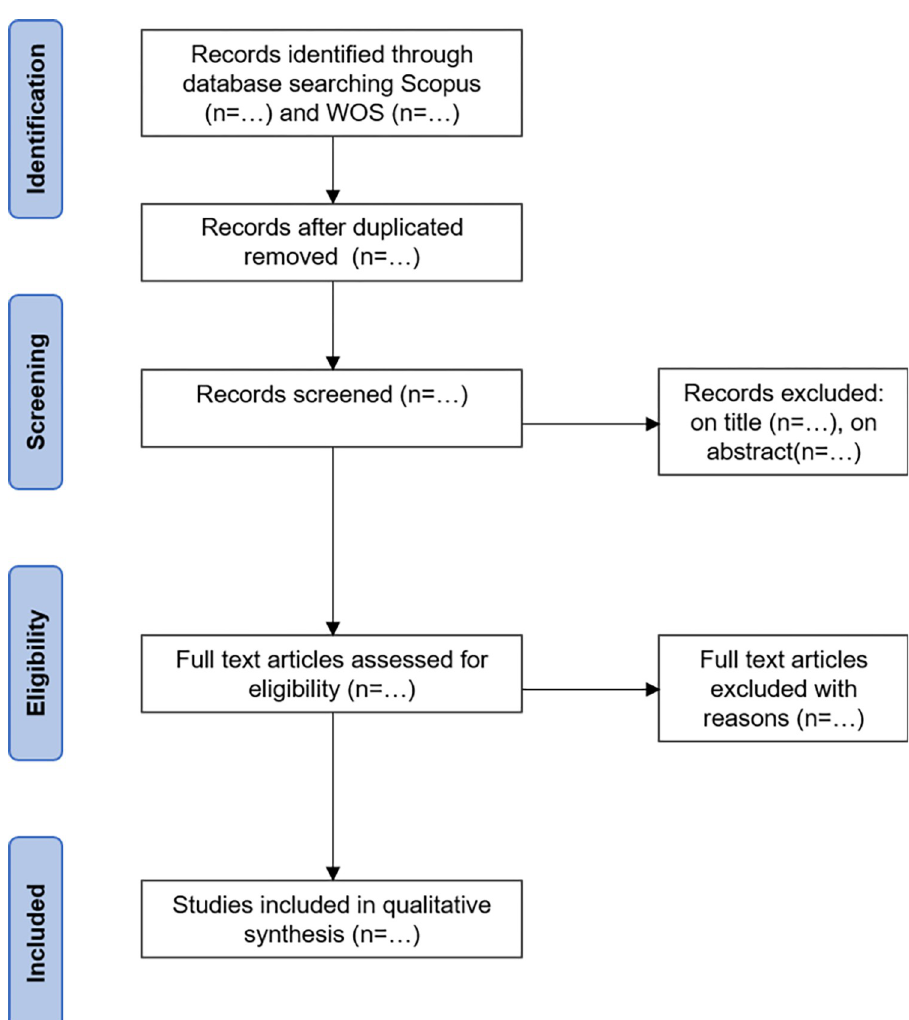
Fig 1. PRISMA flow chart that will be completed in the final scoping